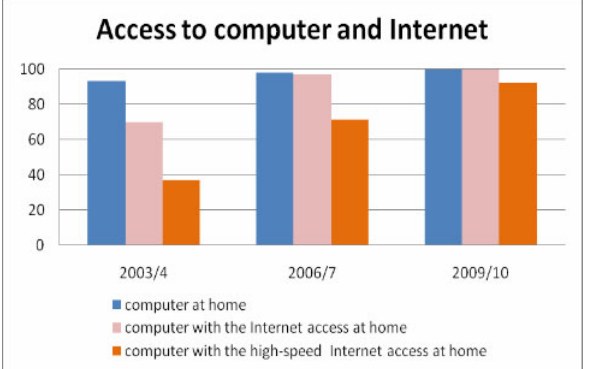
Figure 4. Access to computer and the Internet